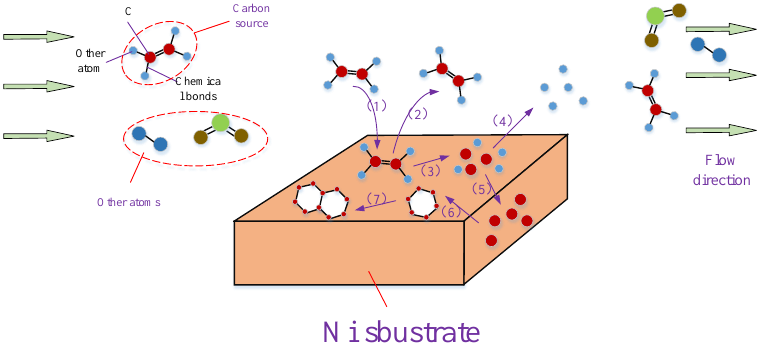
Figure 6. Mechanism of CVD growth graphene on Ni.